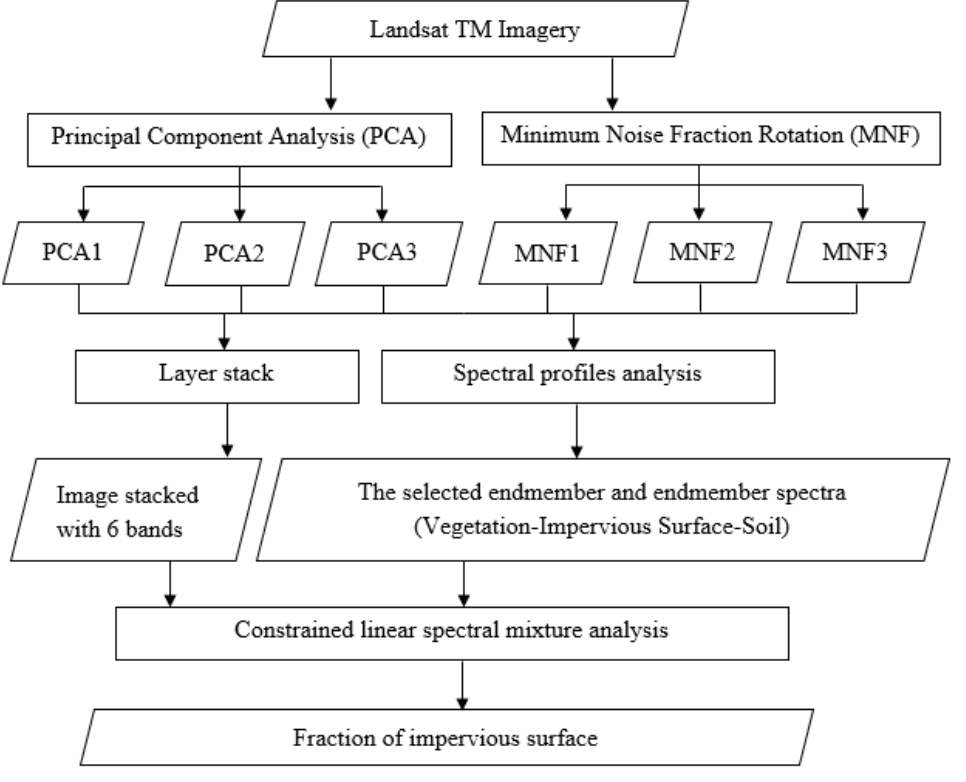
Figure 2. The flowchart of the proposed method.